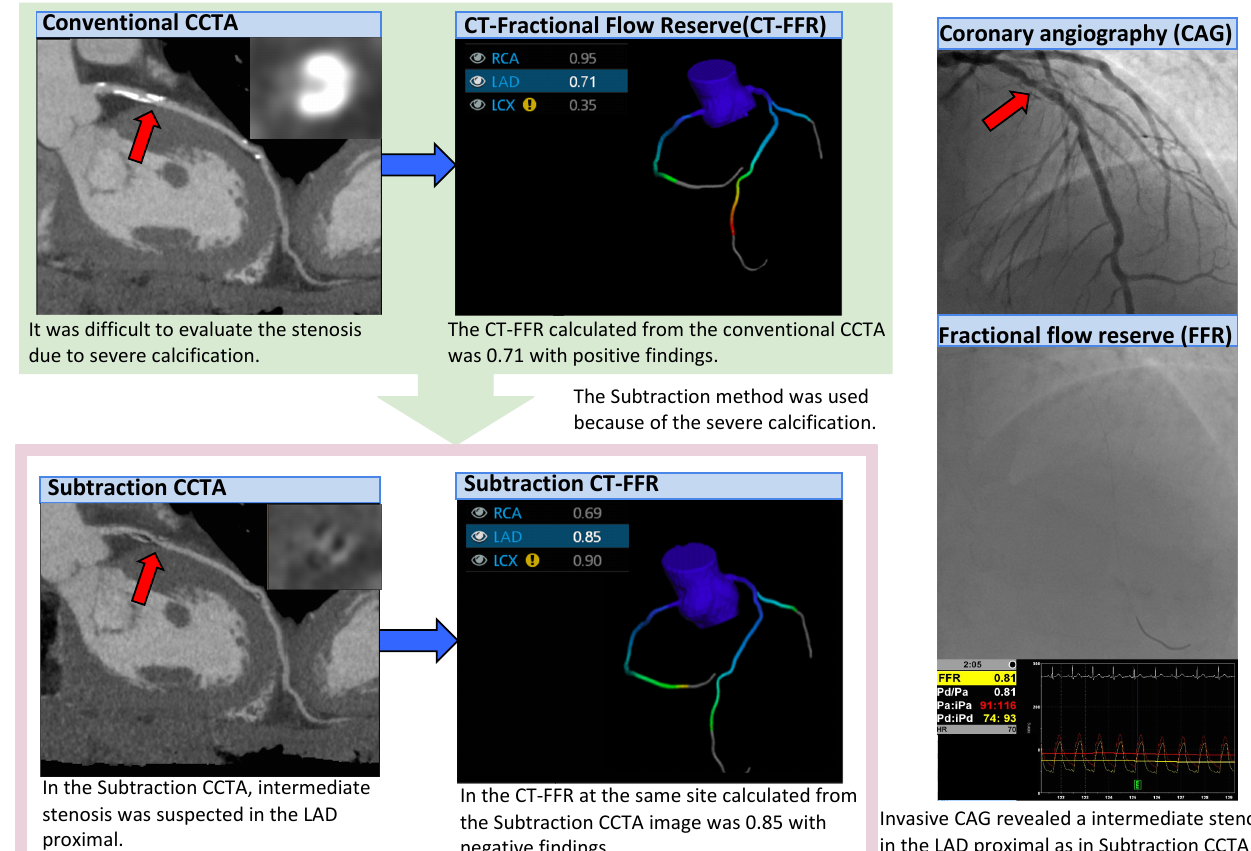
Figure 2. Representative case of subtraction CT-FFR. Since the Agatston score was 738.8, CCTA was performed using the subtraction method. In conventional CCTA, a calcified plaque was found in the LAD